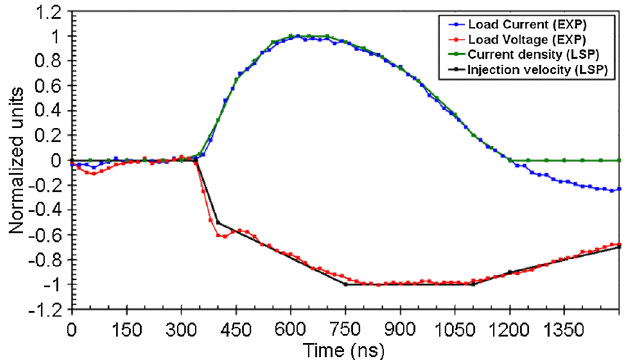
FIG. 10. (Color) Input parameters used in PIC simulation for the injected ion species in the ferroelectric source. The peak current (cid:6) (cid:1) 10 mA cm (cid:1) 2 , and the peak radial injection density is J i r (cid:6) (cid:1) 0 : 375 cm (cid:1) s (cid:1) 1 velocity is v i r